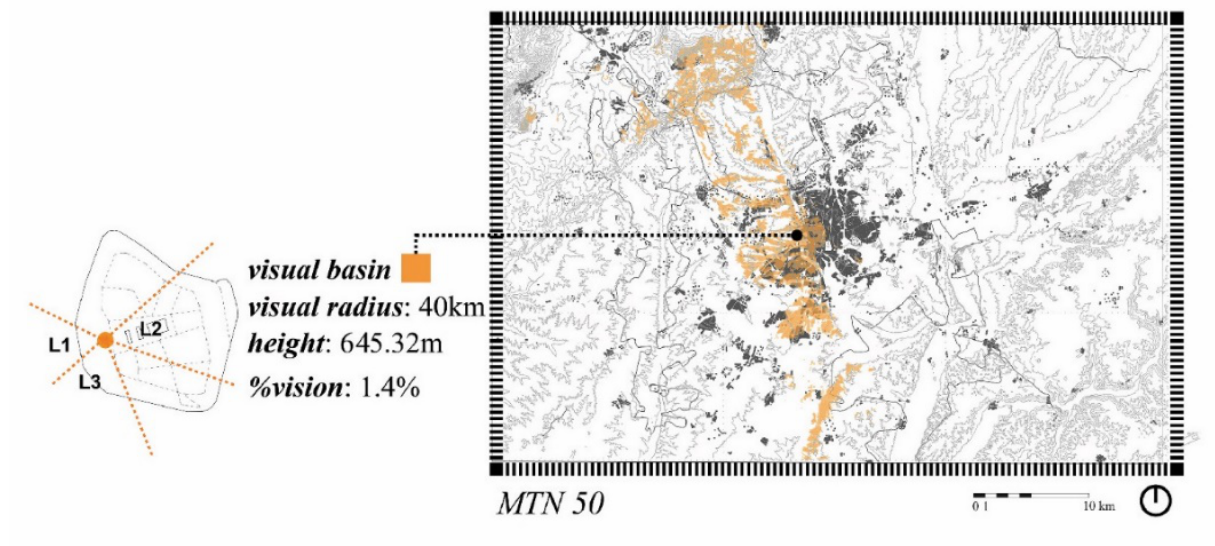
Figure 4: Potentially visible areas from ‘Temple of Debod’